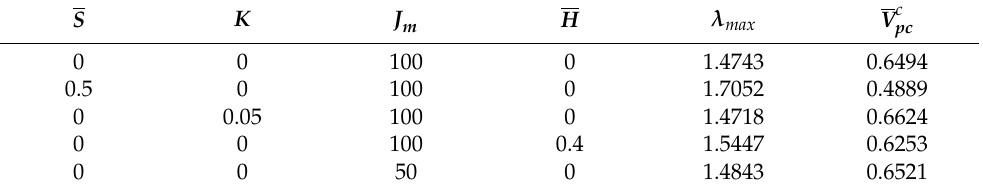
Table 3. The static critical voltage V DC and static critical stretch λ max